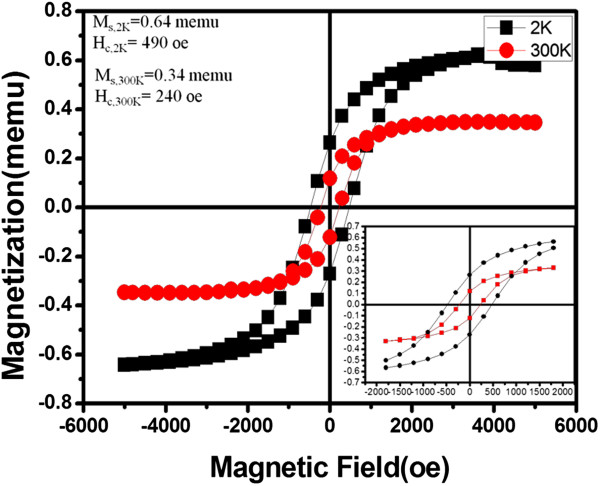
M-H curve of δ-Ni2Si NWs measured at different temperatures. The inset is the highlight of the magnetization.